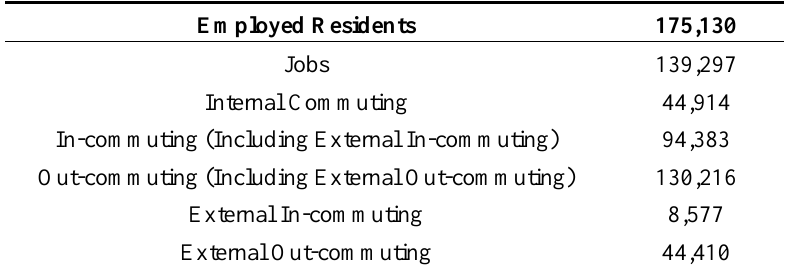
Table 1. Commuting statistics for